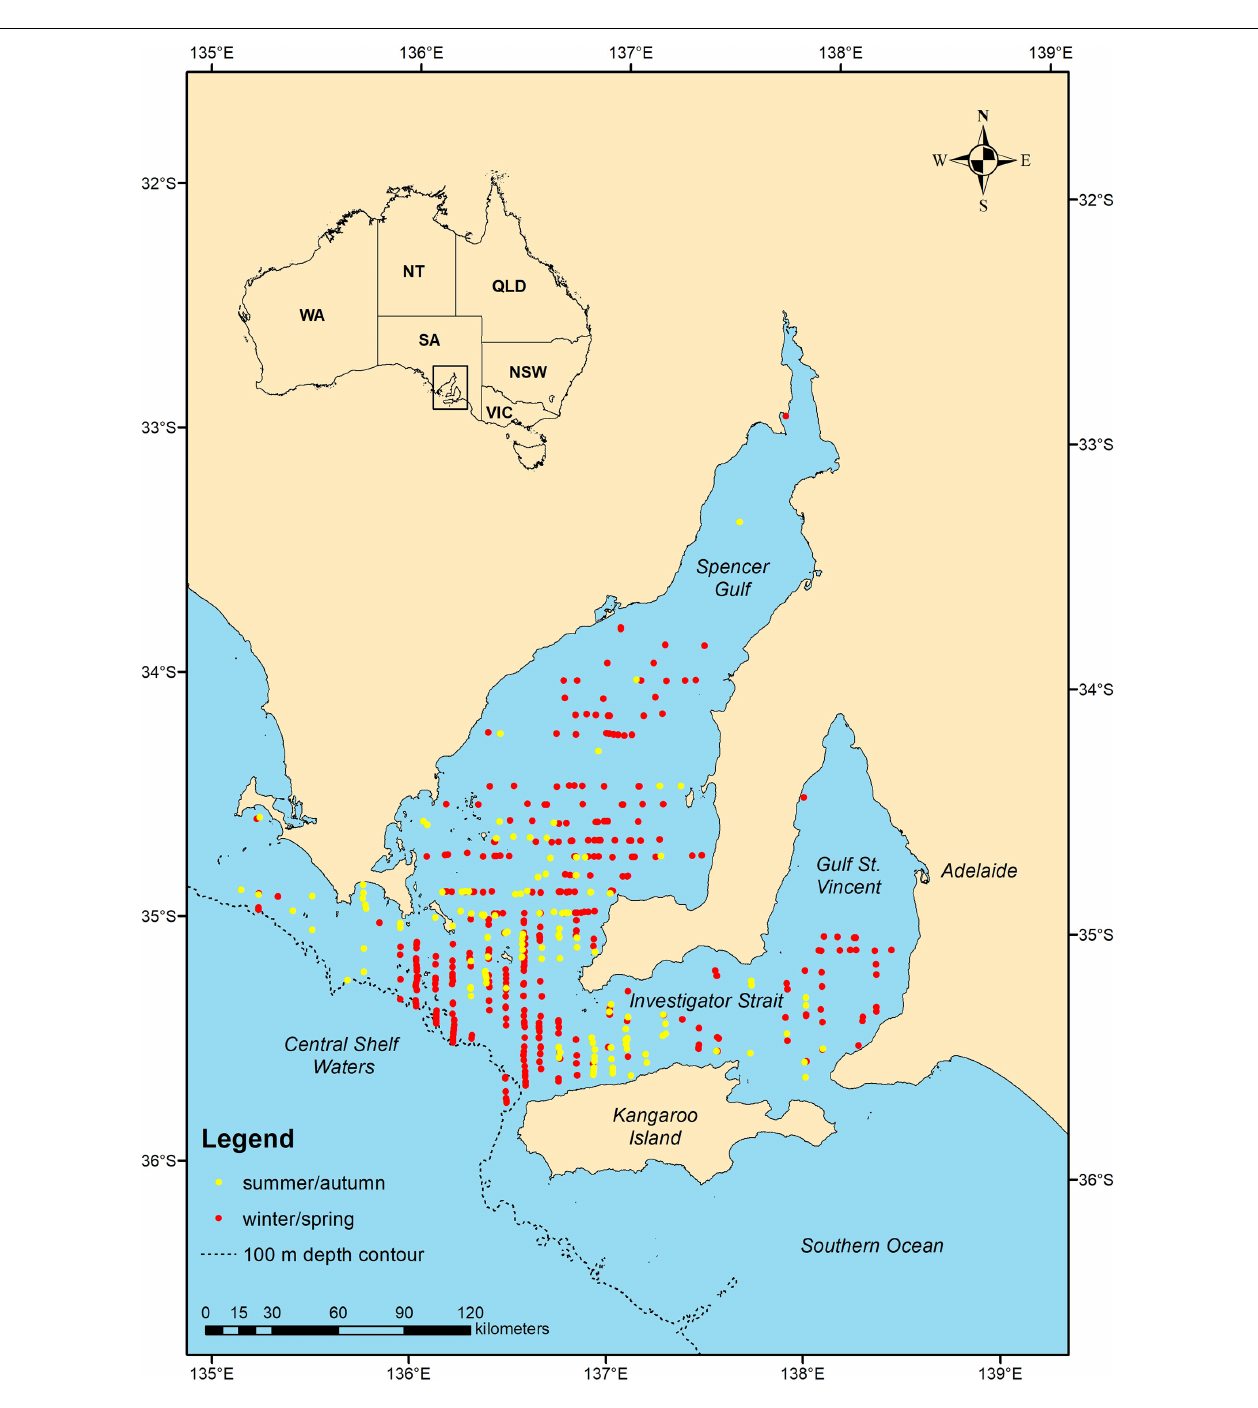
FIGURE 2 | Map showing the distribution of common dolphin ( Delphinus delphis ) schools sighted (unique sightings, no truncation) in summer/autumn (yellow dots) and winter/spring (red dots) of 2011 during aerial line transect surveys in central South Australia.